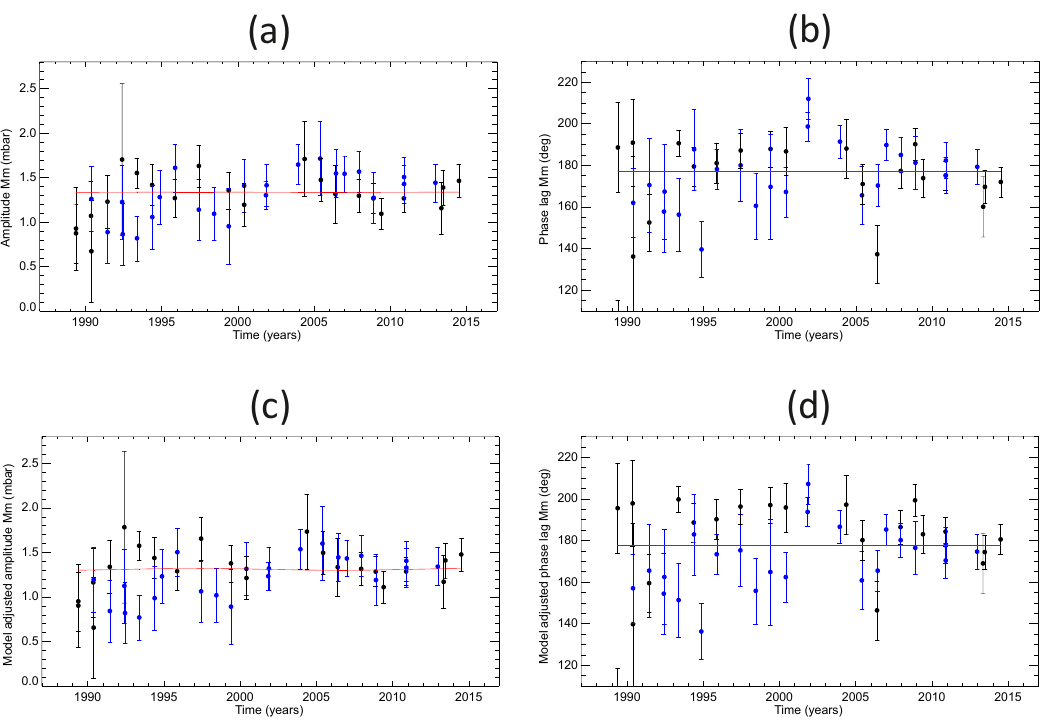
Figure 6. Panels (a, b) are the same as Fig. 5a, b but for the Mm long-period tide. The red line in panel (b) indicates the median phase lag instead of a nodal fit. Panels (c, d) are the same as (a, b) but with adjustments for different deployment locations using the FES2014